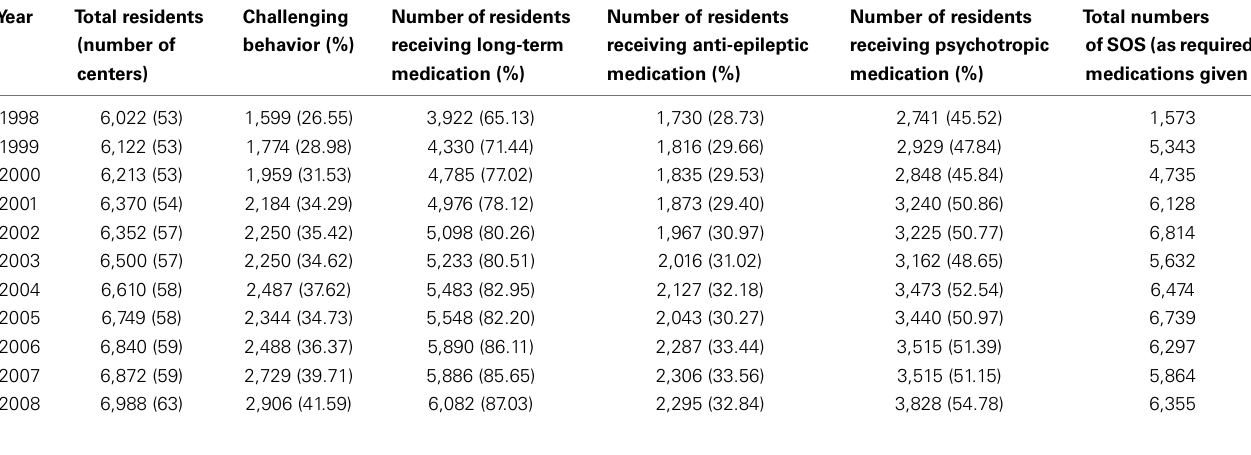
Table 1 |Trends in challenging behavior and medication for people with intellectual